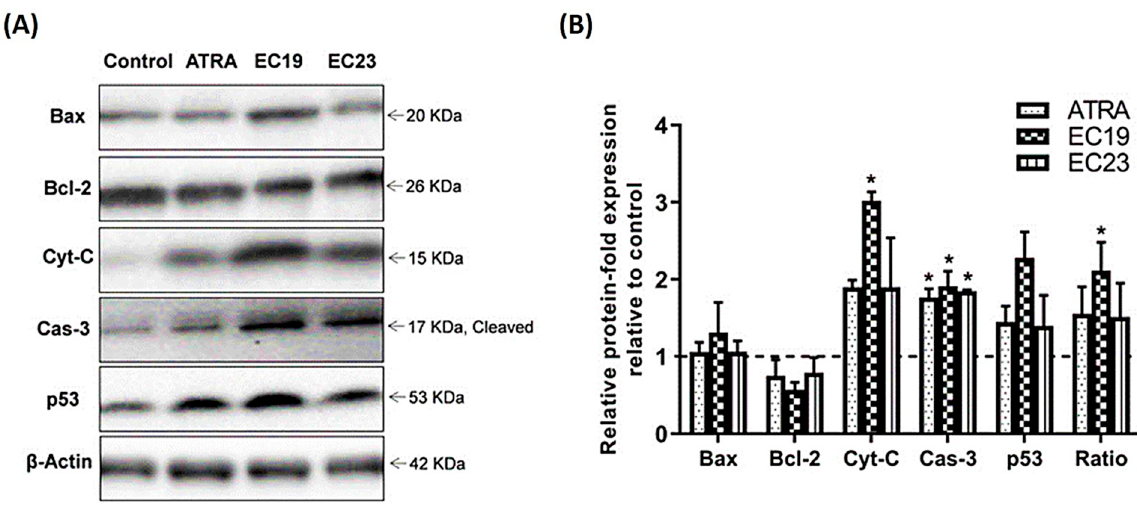
Figure 9. Western blotting analysis of Bax, Bcl-2, Cyt-C, Cas-3 p53 and Ratio (Bax/Bcl-2) in Caco-2 cells. ( A ) Representative immunoblotting images demonstrate the effect of IC 50 dose of ATRA, EC19, and EC23 on the protein expression levels of Bax, Bcl-2, Cyt-C, cleaved Cas-3, and p53 in Caco-2 cells treated for 24 h. ( B ) Quantification of the tested proteins in Caco-2 cell lysates, with normalization to the β -actin protein (dashed line). The expression of all recorded proteins in the control group is set to (“1”), and all data from three separate experiments are fold change of proteins expression to control (dashed line) and shown as mean ± SEM. * p < 0.05 indicates a statistically significant difference from the matching vehicle-treated control group.